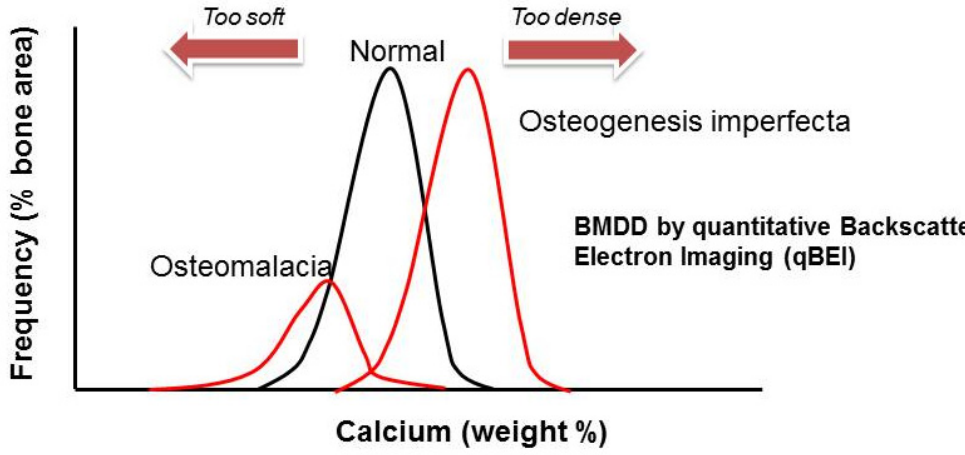
Figure 1. The extremes of bone mineralization density distribution (BMDD): bone tissue in patients with OI has increased mineralization density. This is due to the irregular collagen fibers and their wider spatial distribution which allows more hydroxyapatite deposition. Also depicted is the opposite: low tissue mineralization density in patients with osteomalacia.